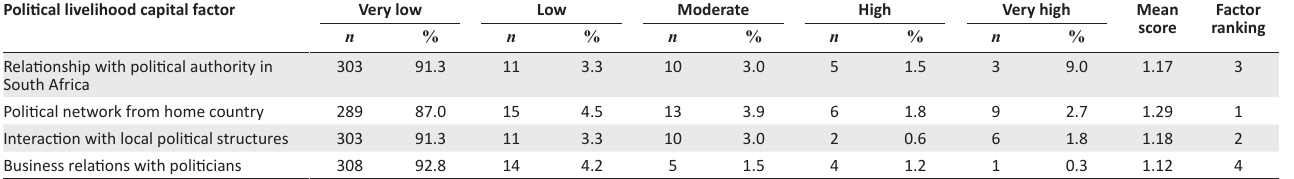
TABLE 7: Ratings of political livelihood factors ( n =